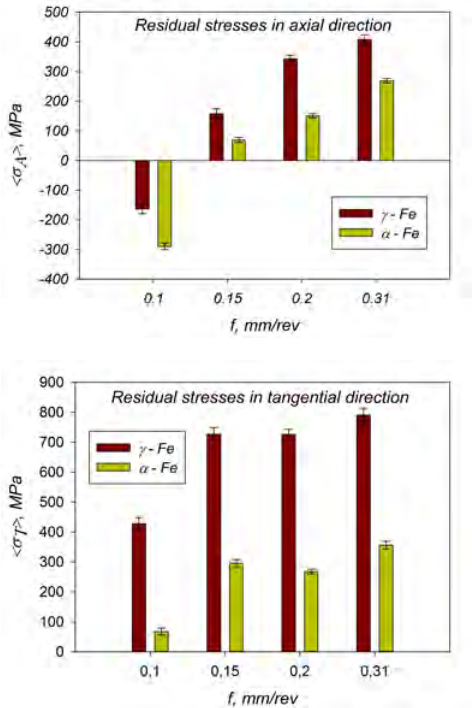
Figure 1. Averaged values of residual stresses h σ A i , MPa (top) and h σ T i , MPa (bottom) of both phases depending on tool’s feed f ,